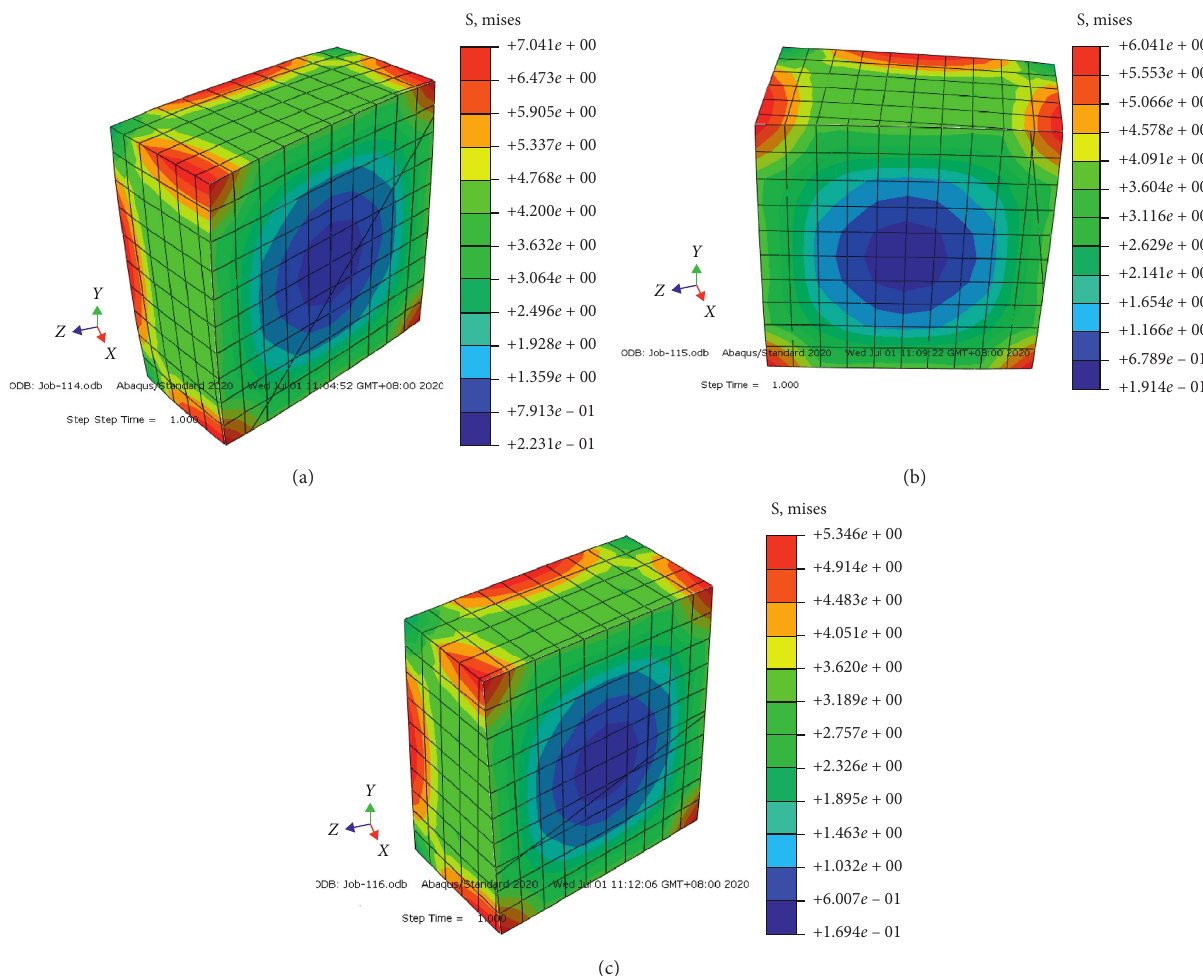
Figure 5: The stress distribution map of rock freeze-thaw cycles: (a) 5 freeze-thaw cycles, (b) 10 freeze-thaw cycles, and (c) 20 freeze-thaw cycles.